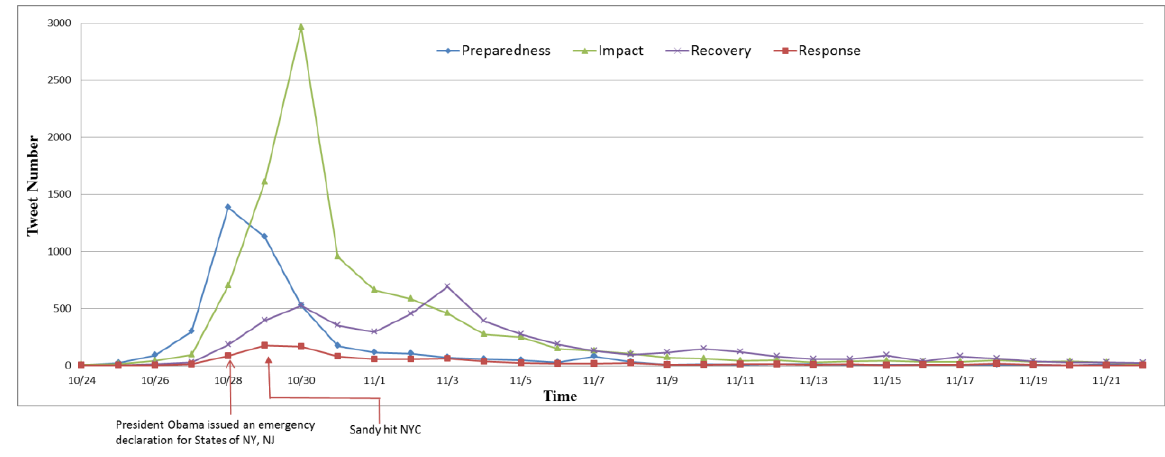
Figure 2. Tweet number in different disaster phases over